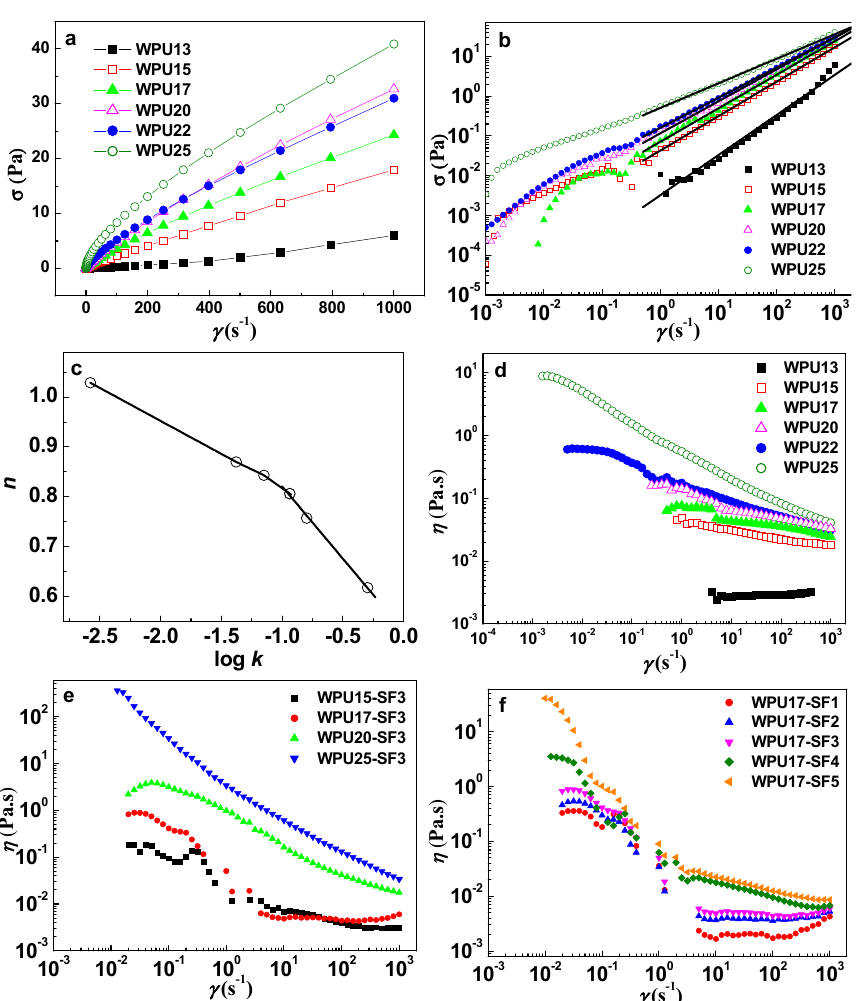
Figure 2. Steady-shear flow behavior of WPU dispersions: dependence of the shear stress σ on the shear rate γ ( a , b ); flow behavior index, n , as a function of log k ( c ); and dependence of the steady shear viscosity on the shear rate for WPU dispersions with different solid contents ( d ); for WPU-SF3 dispersions ( e ); and for WPU17-SF ( f ) at T = 25 °C, respectively.